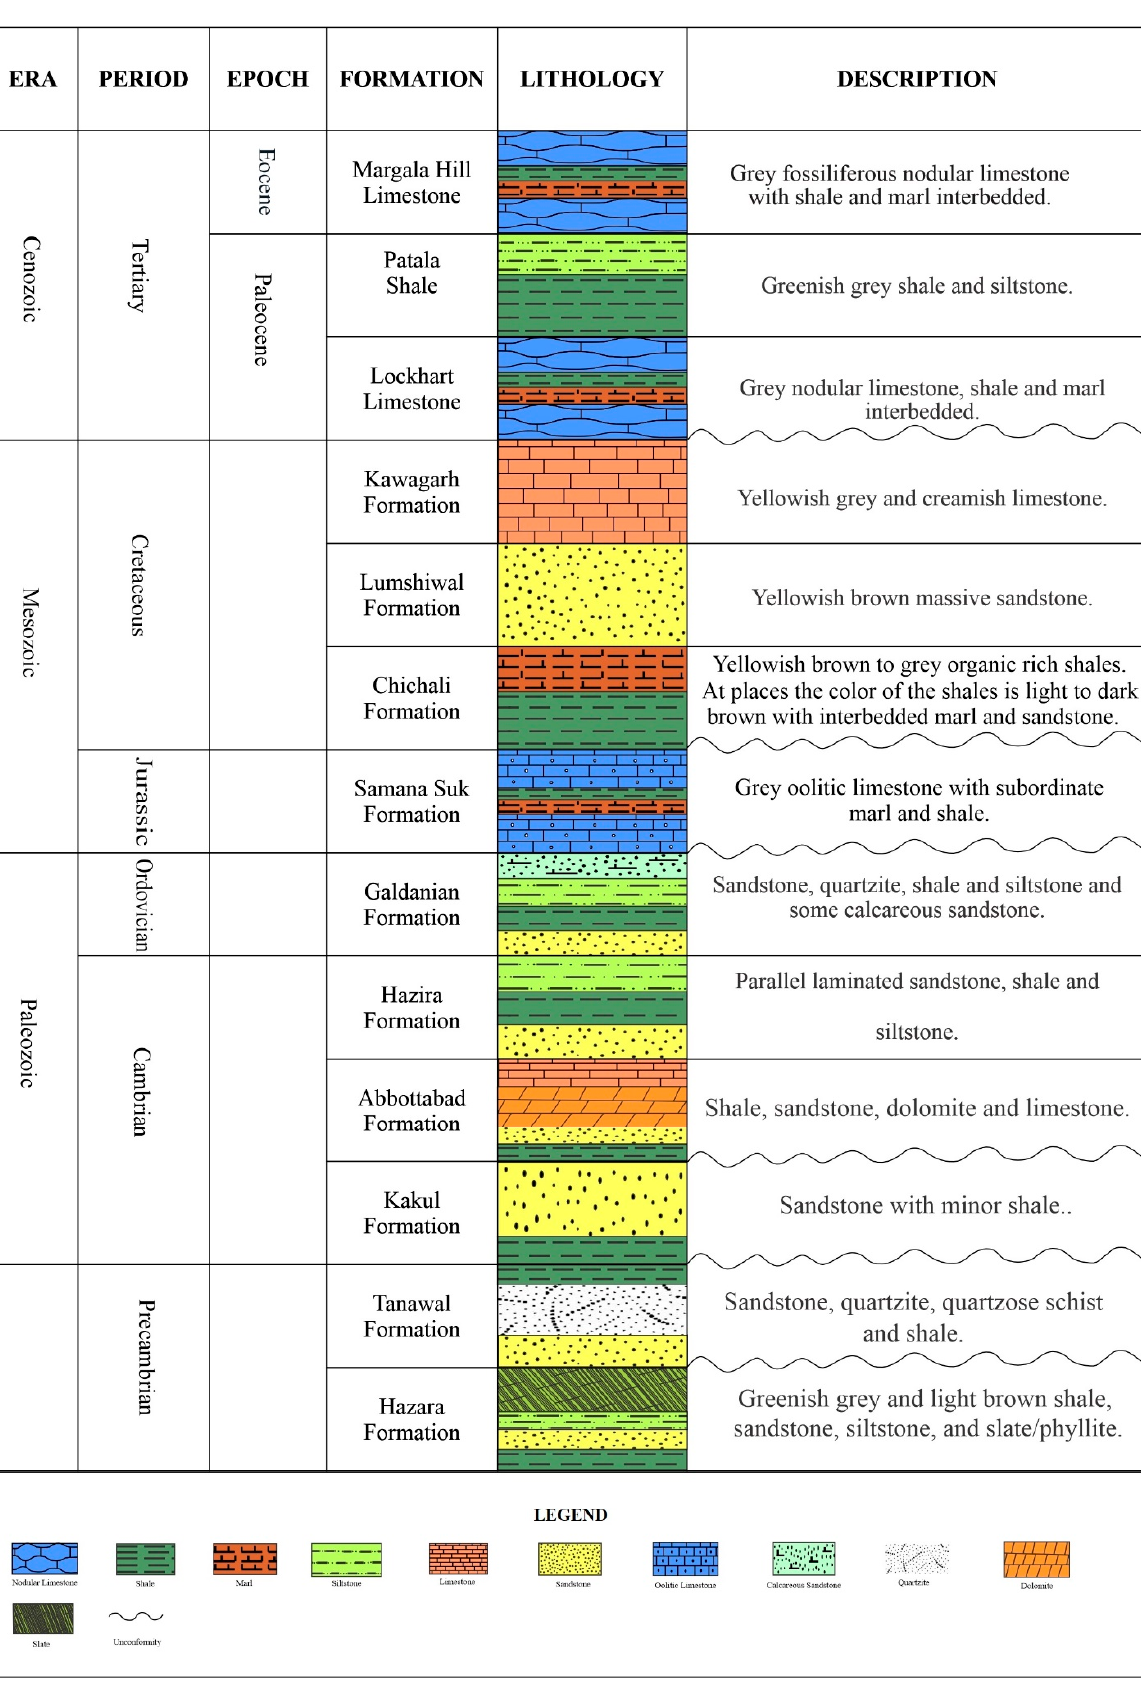
Figure 2. Representation of the generalized stratigraphic succession of the Hazara Basin.